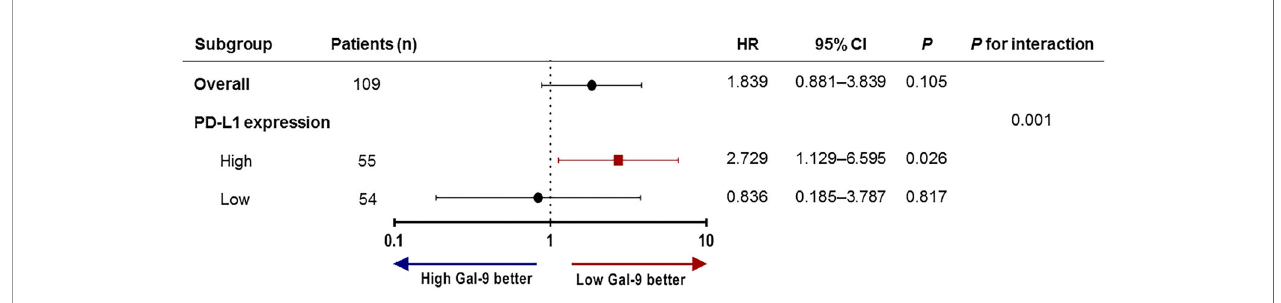
FIGURE 5 | Subgroup analysis and forest plot of OS. Hazard ratios and P -values for interactions are based on Cox regression analysis. OS, overall survival.